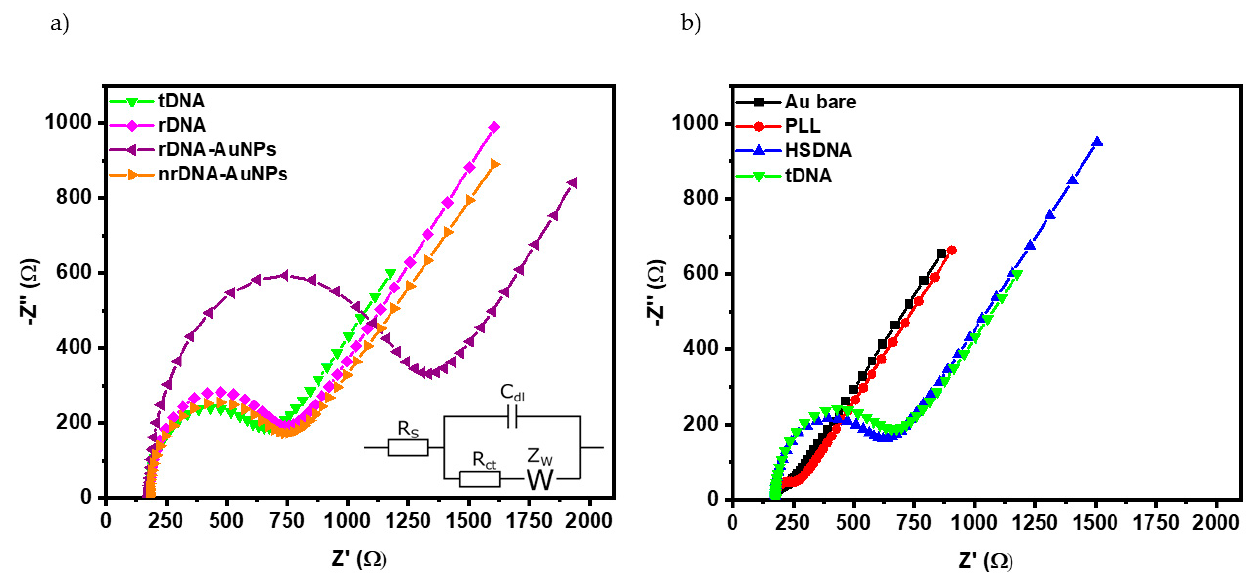
Figure 3. Nyquist plots of the EIS data of: ( a ) Hybridization steps of the t-DNA, followed by rDNA or the amplification step with the rDNA-AuNPs (0.66 nM), and a control experiment with non- complementary nrDNA-AuNPs (0.7 nM); ( b ) bare gold substrate before and after the subsequent adsorptions of PLL-OEG 22 -Mal 4,6 , HS-DNA probe, and 1 uM tDNA. All the experiments were performed in 100 mM K 2 SO 4 with 1 mM [Fe(CN) 6 ] 3 − /4 − at a scan rate of 100 mVs − 1 .